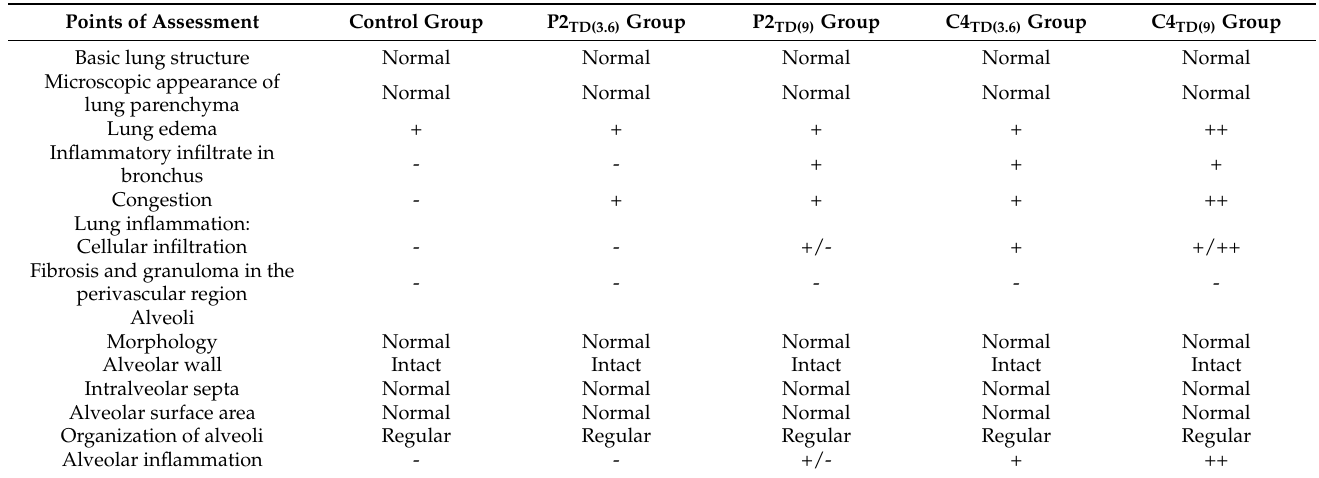
Table 9. Detailed histopathological assessment of rat lung tissues after oro-tracheal administration of different